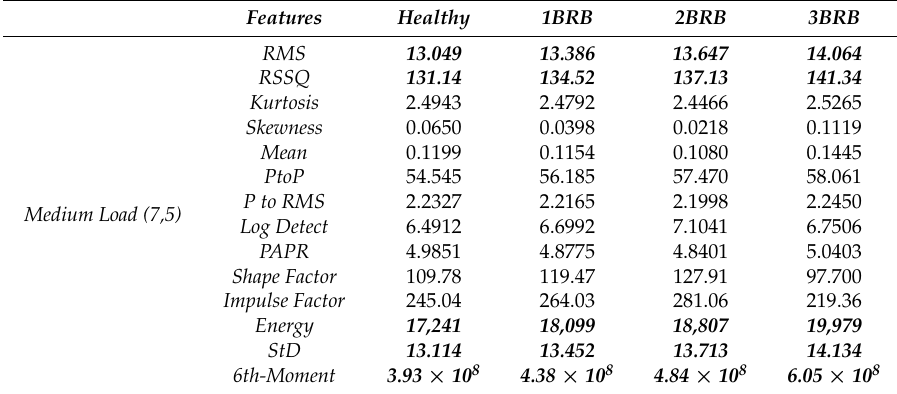
Table 4. Mean Value of Statistical Features for Healthy and Faulty Motor in Medium Load.